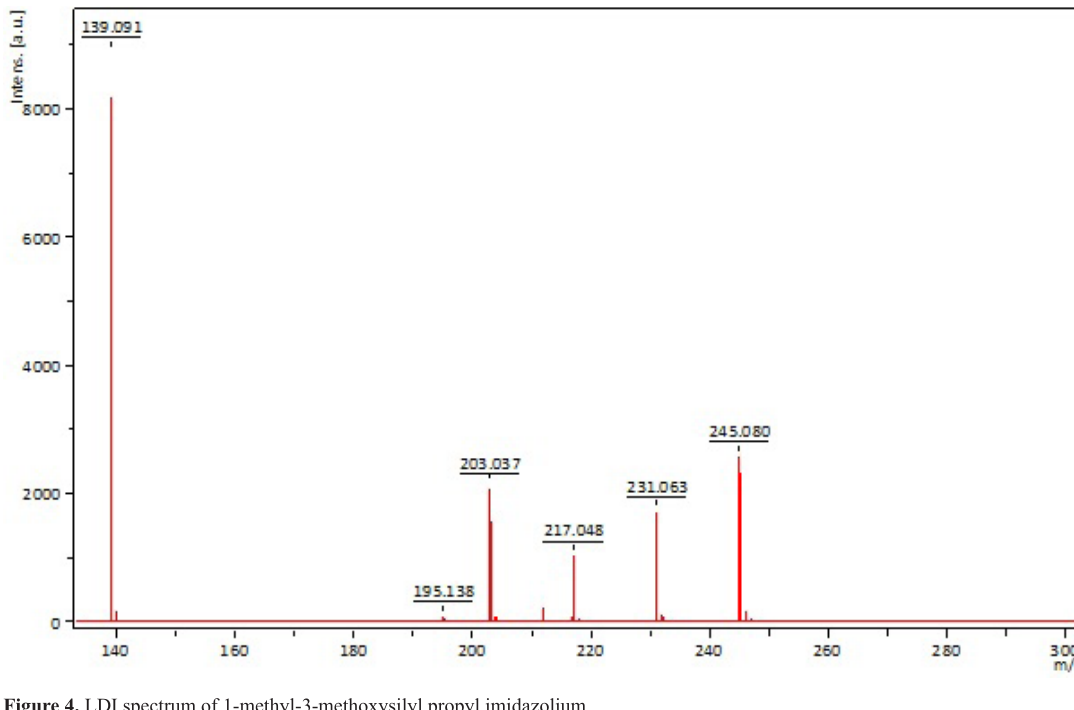
Figure 4. LDI spectrum of 1-methyl-3-methoxysilyl propyl imidazolium